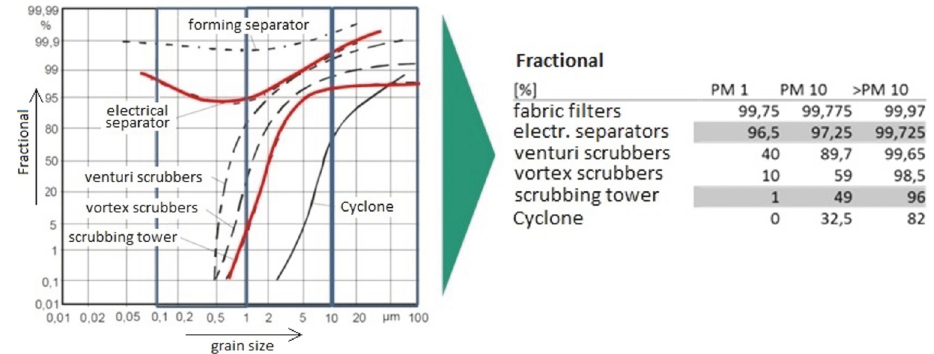
Figure8:Schematicdiagramshowingproceduretodeterminefinesreductionpotentialasaresultofoptimizationofexistingplanttechnology